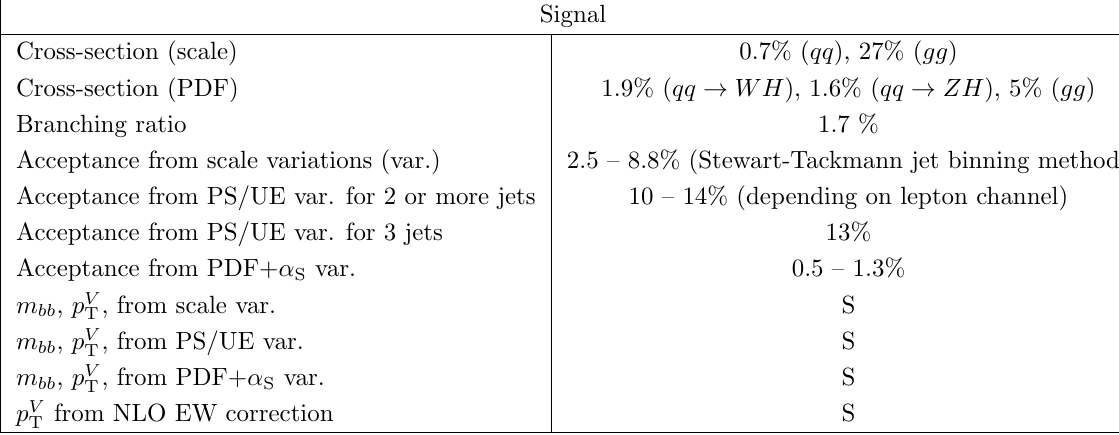
Table 8 . Summary of the systematic uncertainties in the signal modelling. \PS/UE" indicates parton shower / underlying event. An \S" symbol is used when only a shape uncertainty is